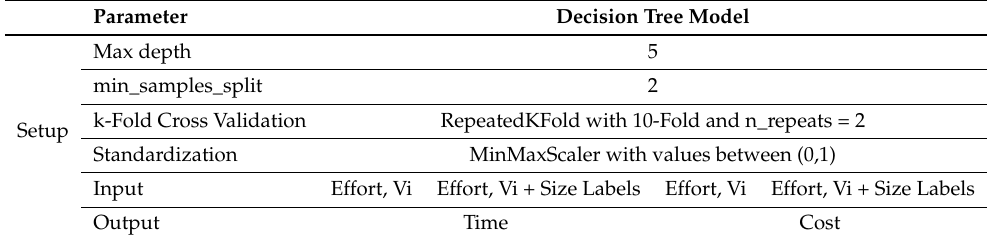
Table 2. Configuration for decision tree